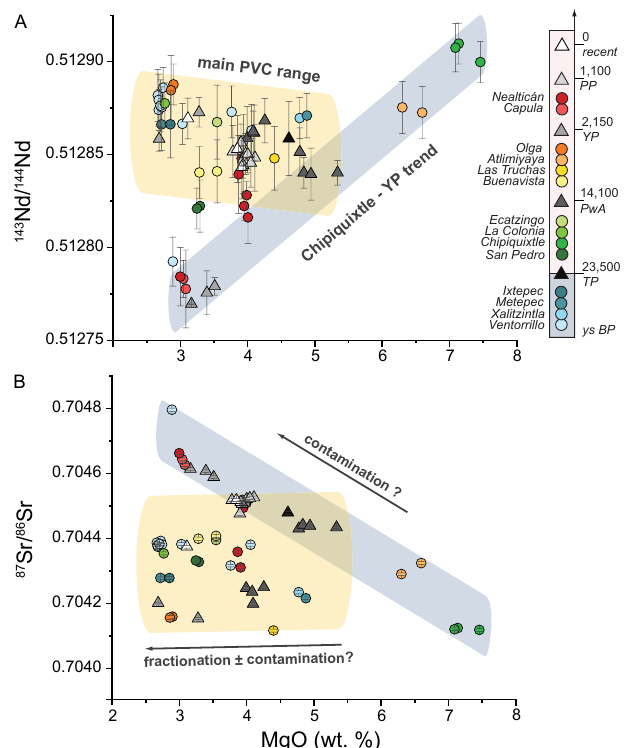
80.70400.70420.70440.70460.7048 MgO (wt. %) Figure 10: [A] 143 Nd/ 144 Nd and [B] 87 Sr/ 86 Sr vs. MgO. The yellow field highlights the main PVC range with no systematic variation in isotopic compositions. The blue field designates a subset of samples showing a cor- relation defined by the Chipiquixtle lava flow and the Yellow Pumice Plinian Eruption, referred to hereafter as the Chipiquixtle–YP trend. See text for further ex-